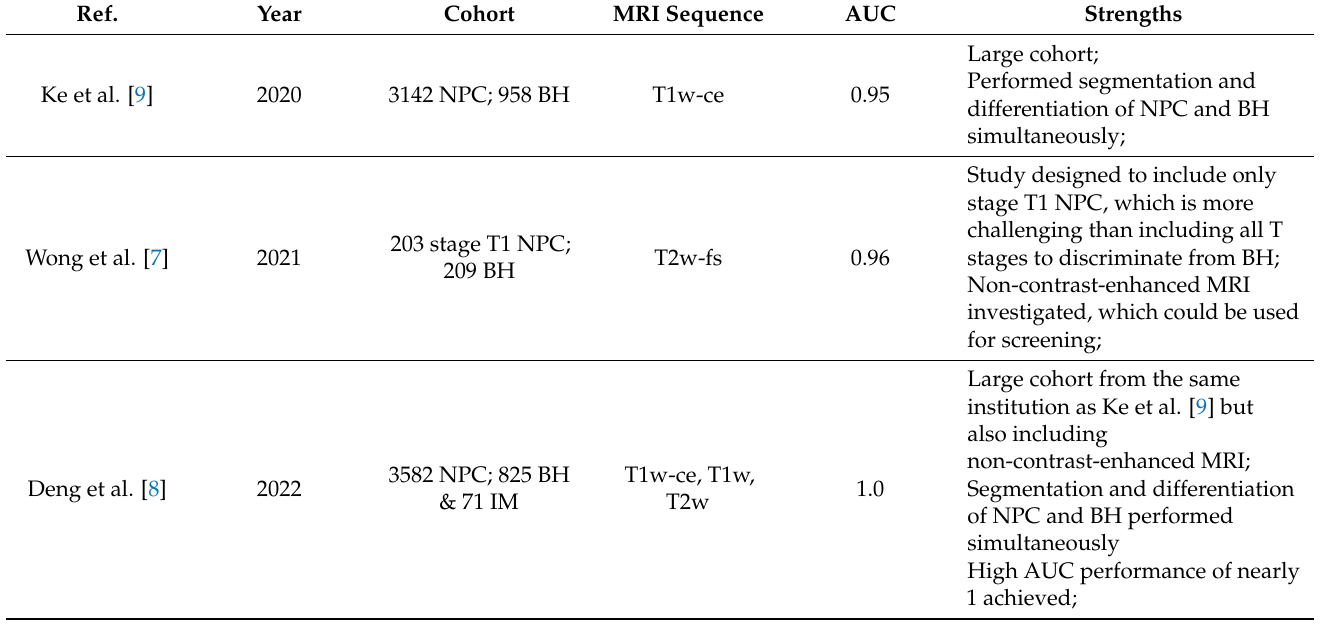
Table 1. Summary of previous convolutional neural network studies for the discrimination of nasopharyngeal carcinoma (NPC) and benign hyperplasia on